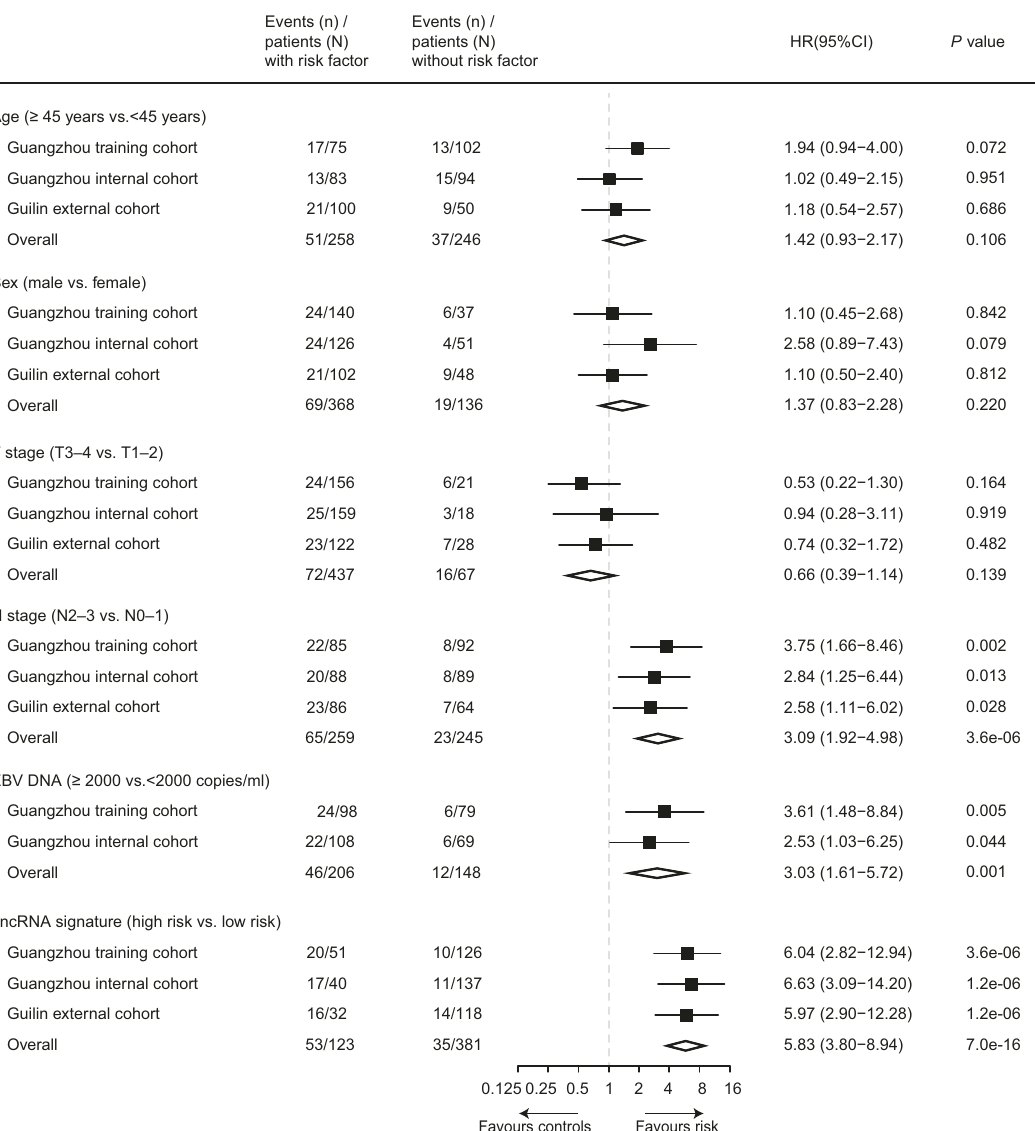
Fig. 3 Forest plots of the nine-lncRNA signature and clinicopathological characteristics on distant metastasis-free survival. Hazard ratios (HR), 95% con fi dence interval (CI), and P values were calculated by an unadjusted Cox proportional-hazards model with a two-sided Wald test. Squares represent the hazard ratios with error bars corresponding to 95% CI bounds. EBV Epstein-Barr virus, HR hazard ratio, CI con fi dence interval. Source data are provided as a Source Data fi